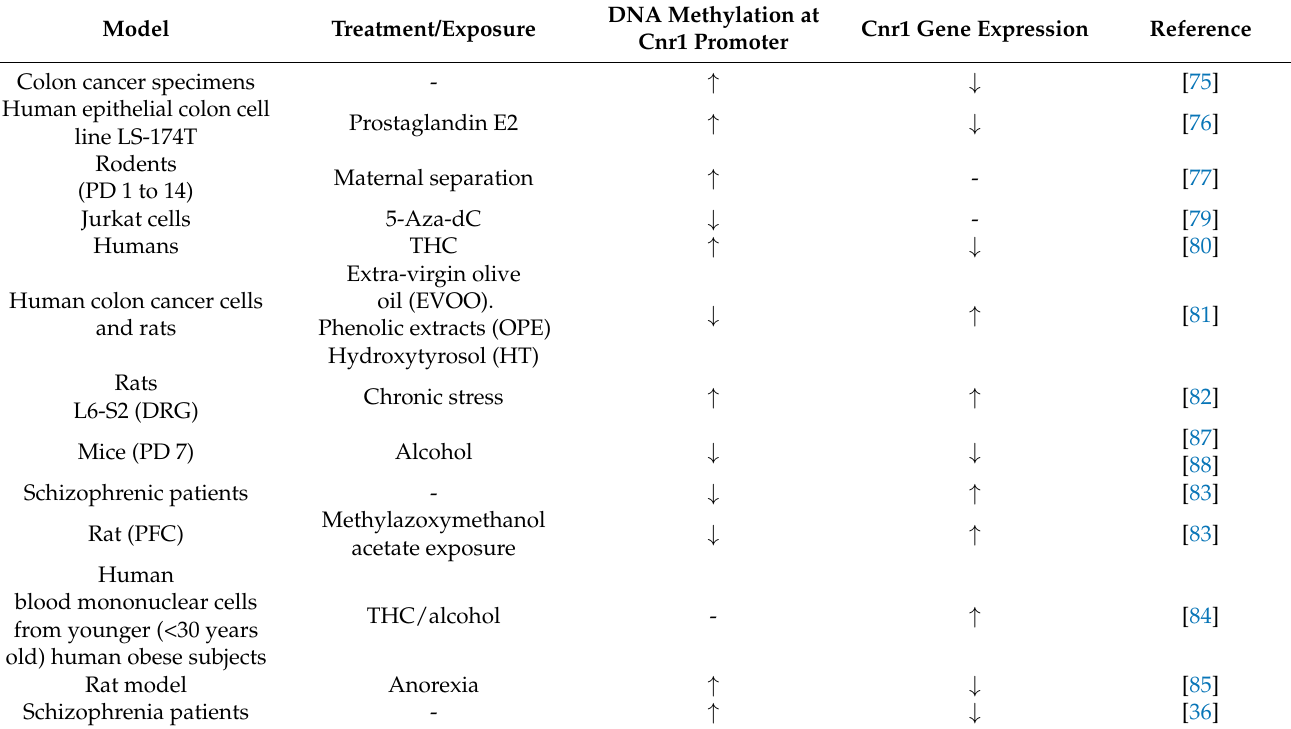
Table 1. DNA methylation and CB 1 receptor gene (Cnr1)